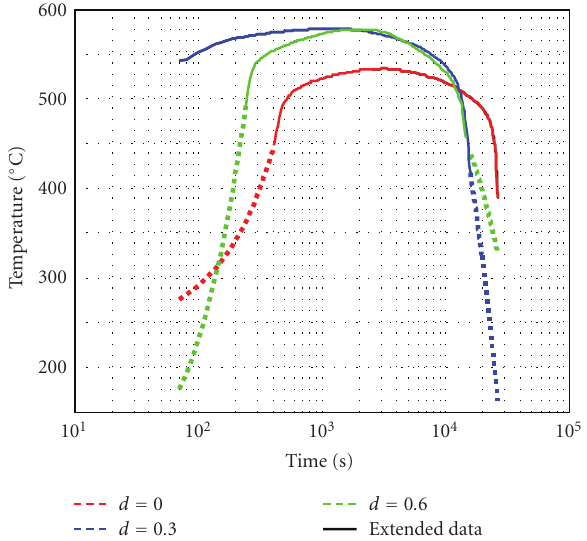
Figure 4: Data extrapolation to the common interval of microstructural transformations for di ff erent degrees of deforma- tion d using smooth padding.